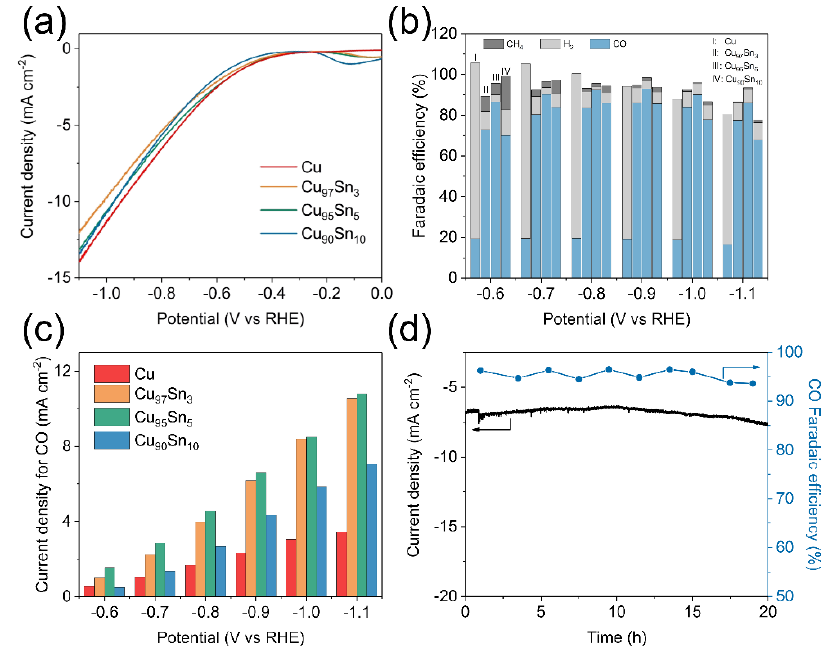
Figure 3. Electrochemical CO 2 reductions in 0.1 M KHCO 3 . ( a ) LSV curves for Cu, Cu 97 Sn 3 , Cu 95 Sn 5 , Cu 90 Sn 10 aerogels. ( b ) Faradaic efficiency for Cu, Cu 97 Sn 3 , Cu 95 Sn 5 , Cu 90 Sn 10 aerogels. ( c ) CO partial current density for Cu, Cu 97 Sn 3 , Cu 95 Sn 5 , Cu 90 Sn 10 aerogels. ( d ) Current density and faradaic efficiency of long-term electrolysis over Cu 95 Sn 5 aerogel electrodes at − 0.9 V vs. RHE.